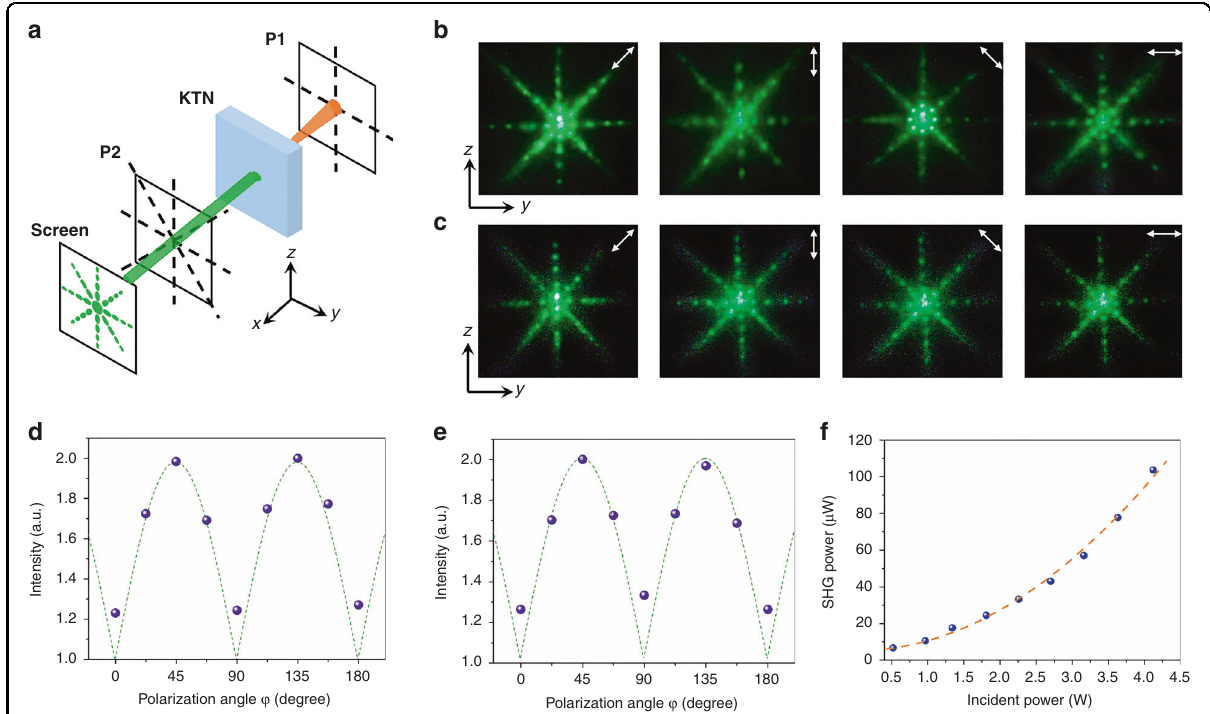
Fig. 4 SH intensity distribution image for different polarizations. a Experimental apparatus for the 3D QPM SHG experiment. b , c SHG spots in different polarization states when the polarization direction of the incident fundamental light is along the y -axis ( b ) and z -axis ( c ). d , e Relative intensity of SHG in different polarization states when the polarization direction of incident fundamental light is along the y -axis ( d ) and z -axis ( e ). f The relationship between the fundamental power and SH